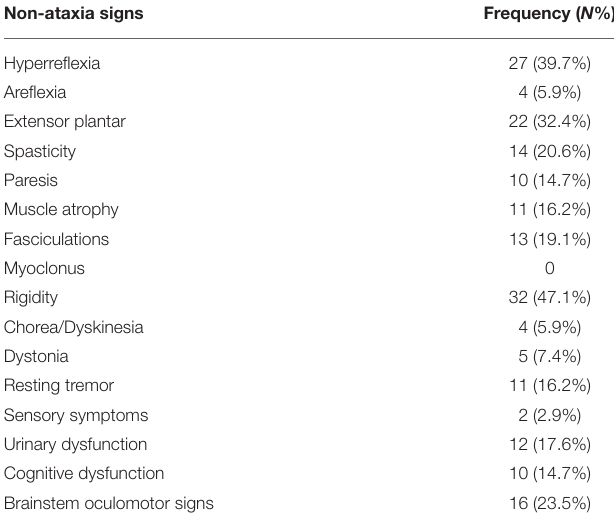
TABLE 2 | Frequency of Extra-cerebellar signs in SCA3 patients.